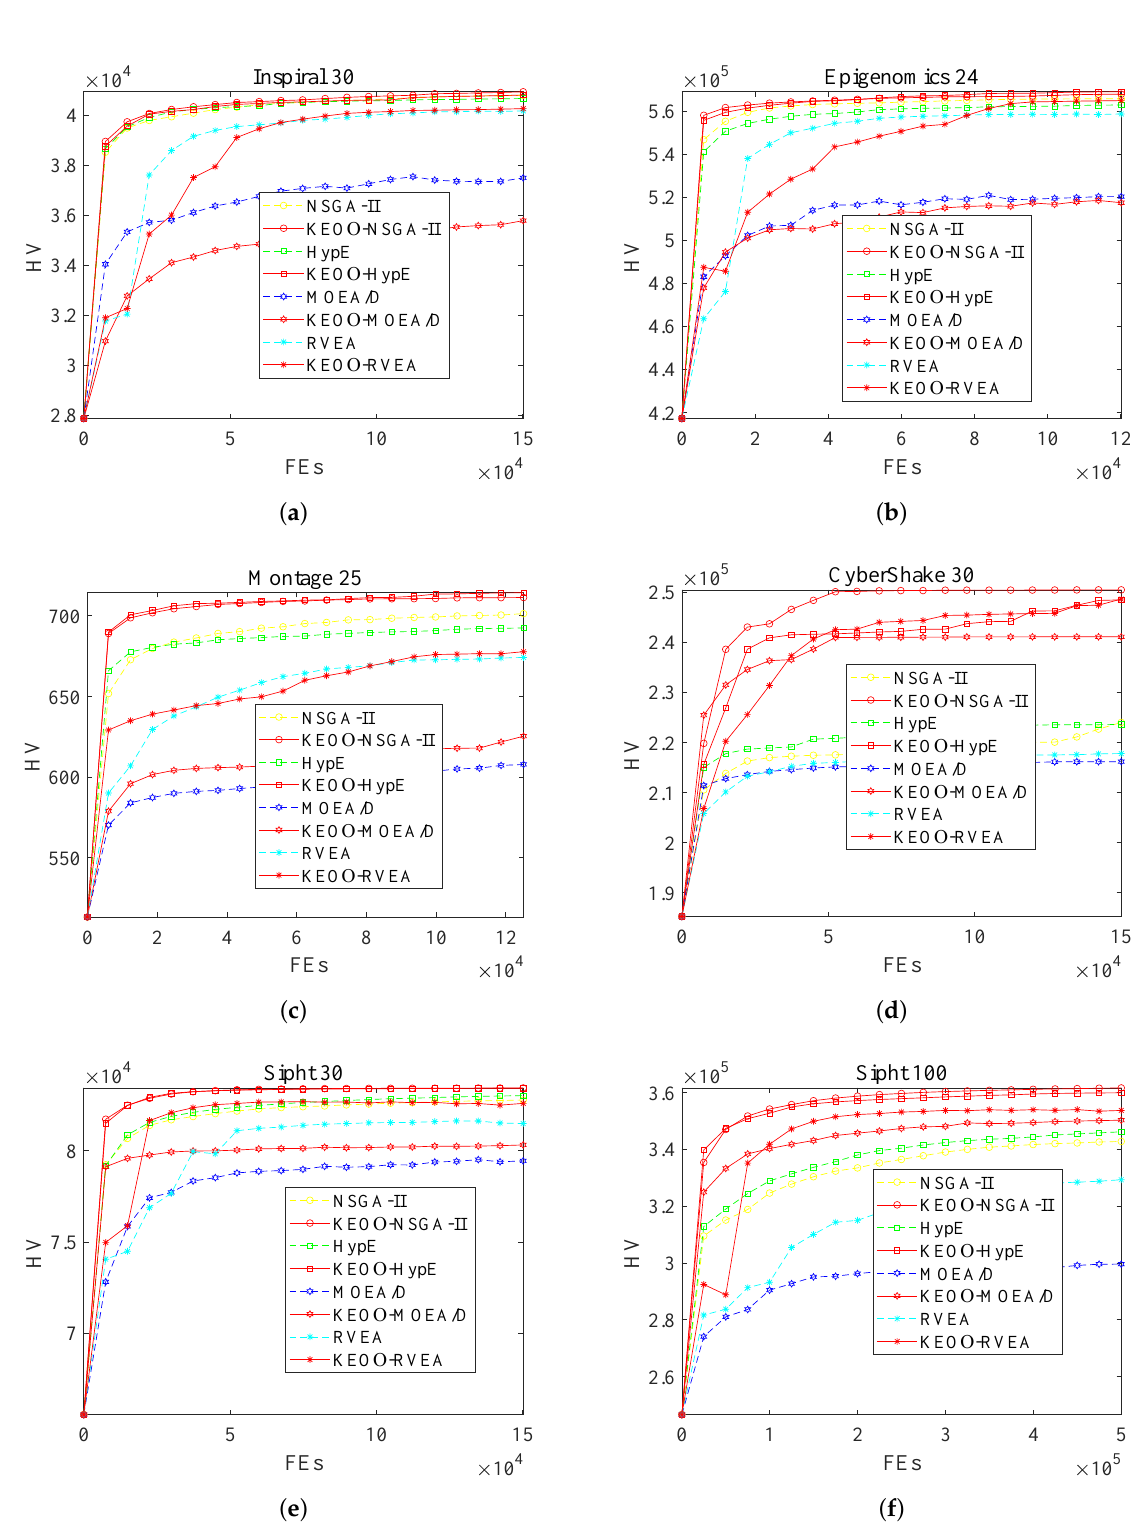
Figure 7. Change of hypervolume values with the advance of evolution. ( a ) on Inspiral with 30 tasks; ( b ) on Epigenomics with 24 tasks; ( c ) on Montage with 25 tasks; ( d ) on CyberShake with 30 tasks; ( e ) on Sipht with 30 tasks; ( f ) on Sipht with 100